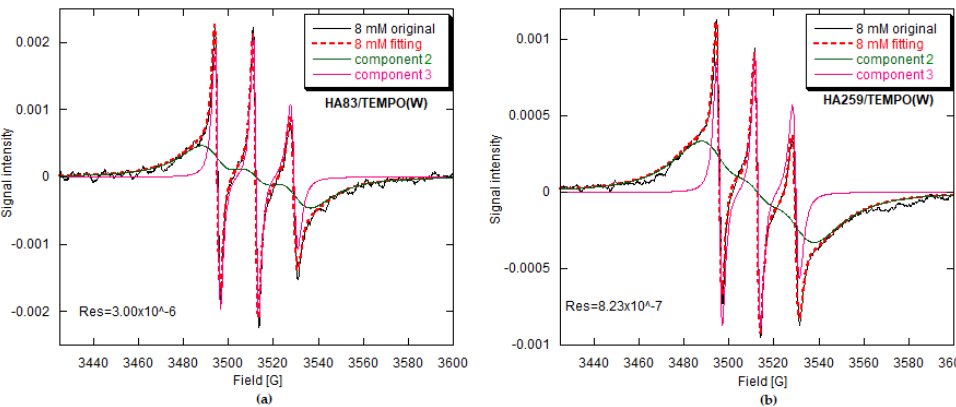
Figure 6. The original and simulated EPR spectra of the composites prepared using the 8 mM aqueous solutions of TEMPO: ( a ) HA83/TEMPO(W); ( b ) HA259/TEMPO(W).